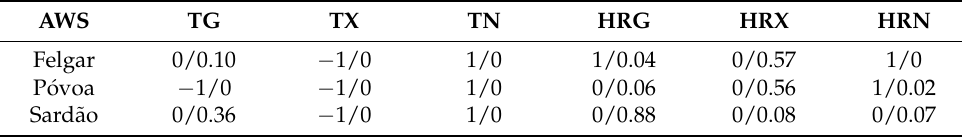
Table 2. Spearman rho test results and p -values (X/Y) for the climate variables of the three AWS.